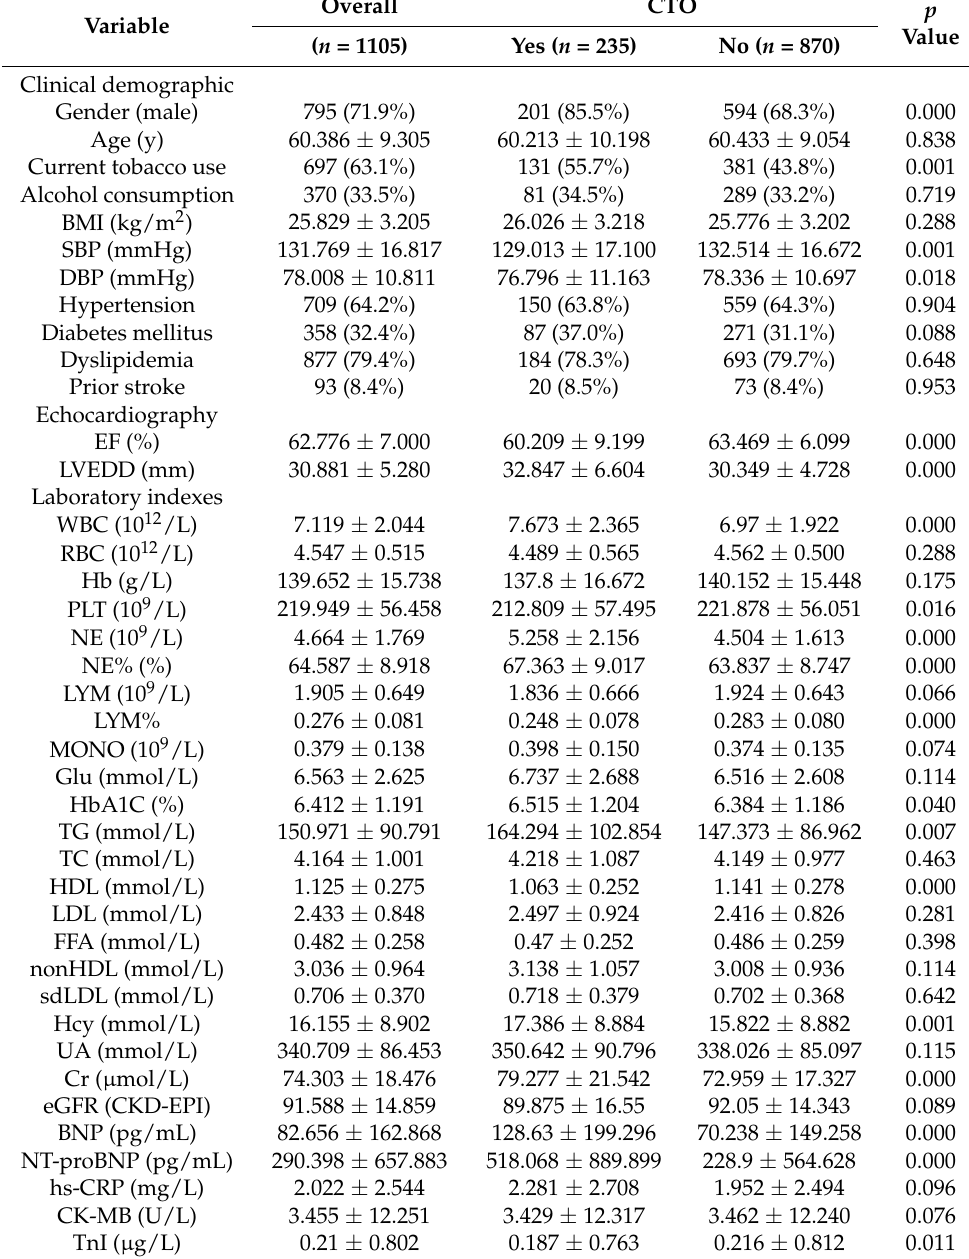
Table 5. Clinical characteristics of the training